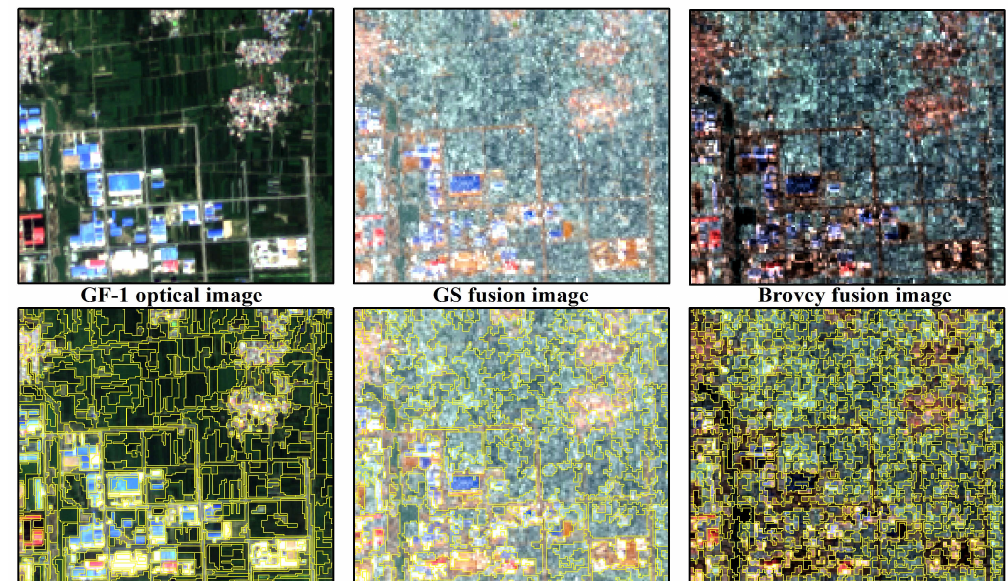
Figure 4. The segmentation results of the optical and fusion images (displayed in partial study area)